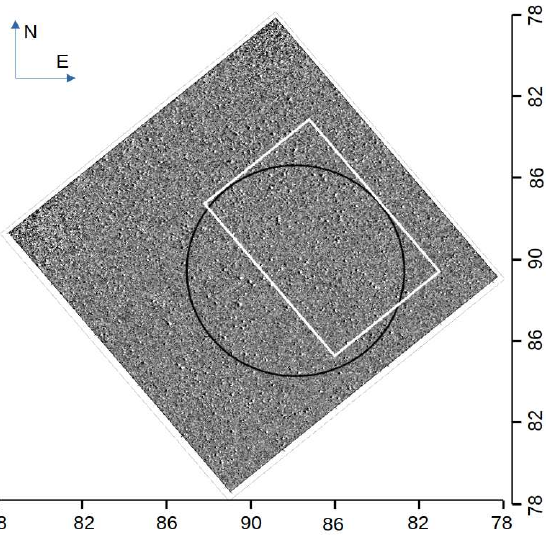
Figure 1. Photometric model CCD camera frame oriented to the cardinal points. The elevation angles are plotted along the axes (zenith is 90°). The black circle marks the 557.7nm photometer channel FOV. The white rectangle is the region with the greatest response to pumping during the E s layer